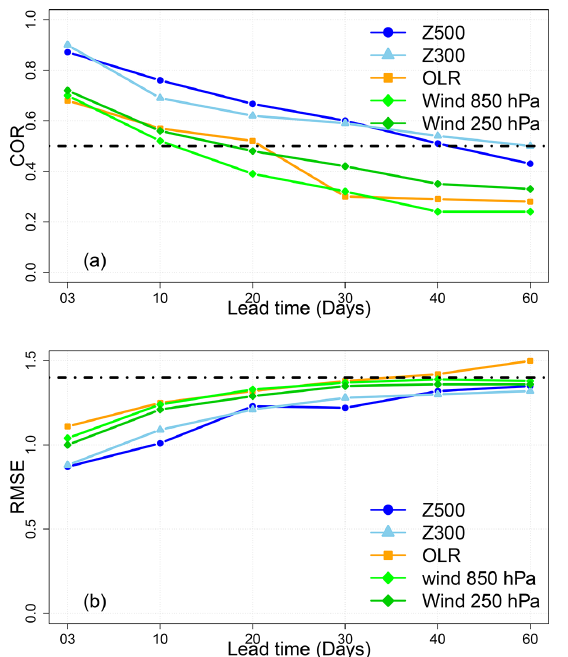
Figure 4. COR (a) and RMSE (b) values for different lead times of forecasts from 3 to 60d over the period from 1979 to 2020 for the SWG forecast using analogs of OLR and zonal wind speed at 250 and 850hPa as well as Z300 and